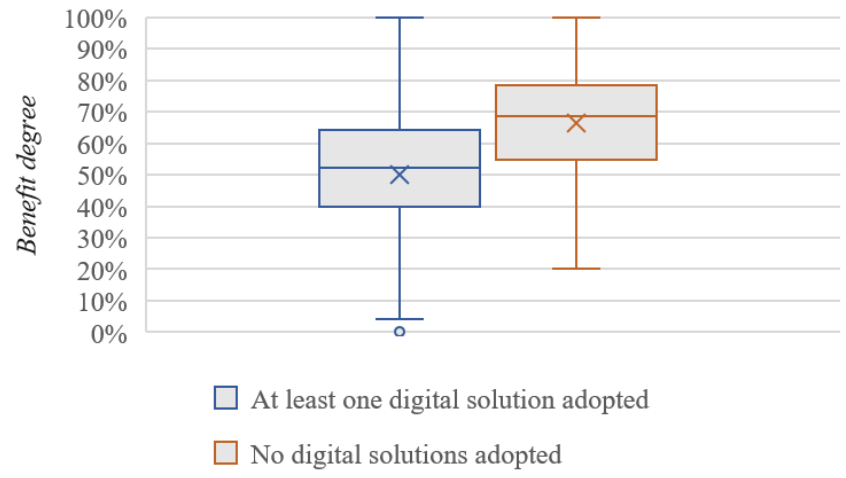
Figure 10. Boxplot graph of the level of benefit between users and nonusers.